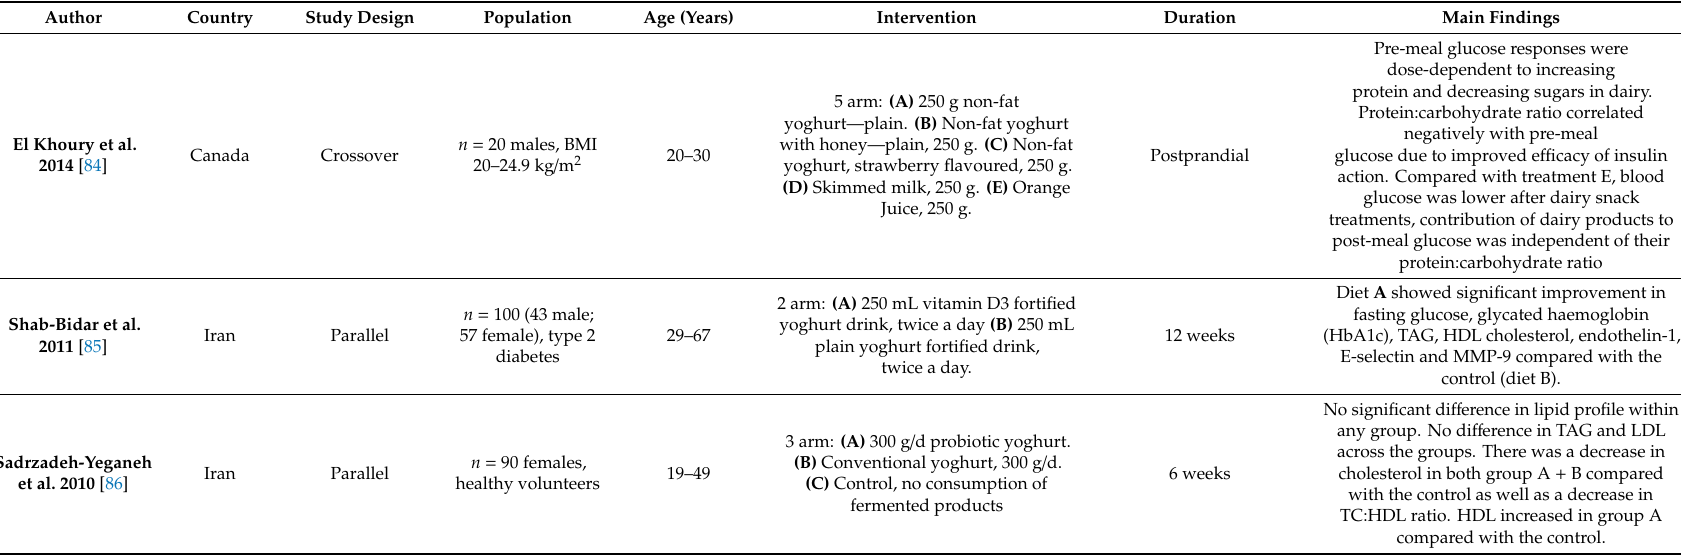
Table 4. Randomised controlled trials (RCT) demonstrating an e ff ect of yoghurt consumption on markers of metabolic health and CVD